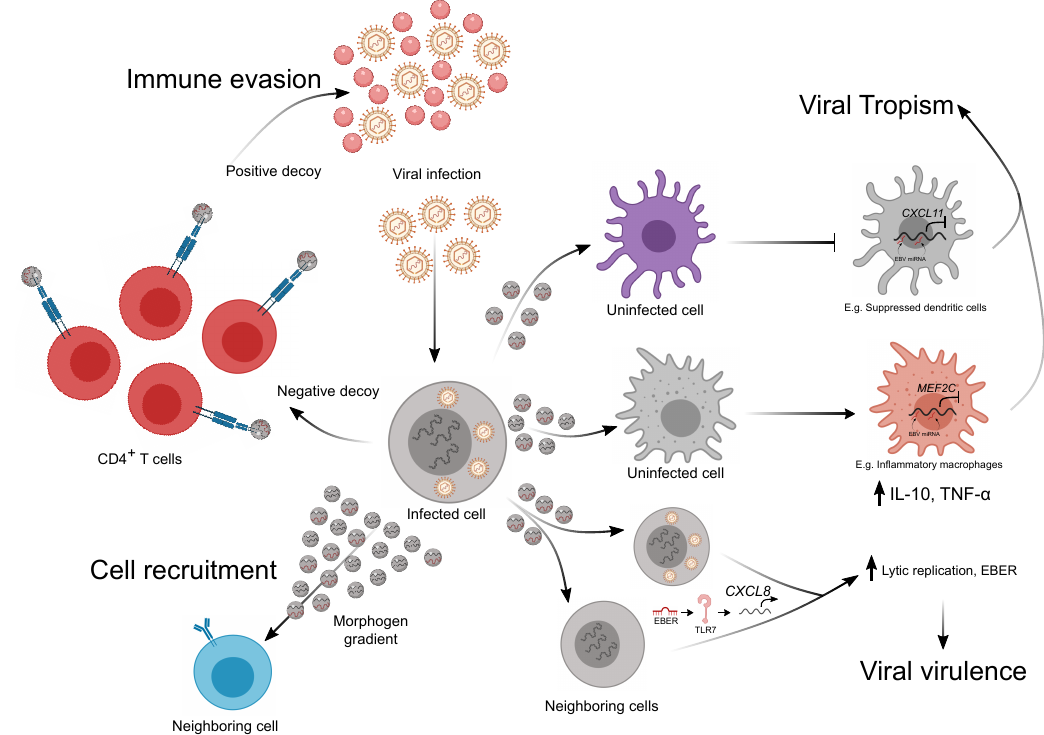
Figure 2 Figure 2. Extracellular vesicle-mediated immune–viral regulation during infection. This figure depicts the potential mechanisms by which virus-encoding EVs could alter virus–host interactions mediated by specific viral EV molecular cargo as indicated. These include the regulation of immune evasion, viral tropism, viral virulence, and potentially immune cell